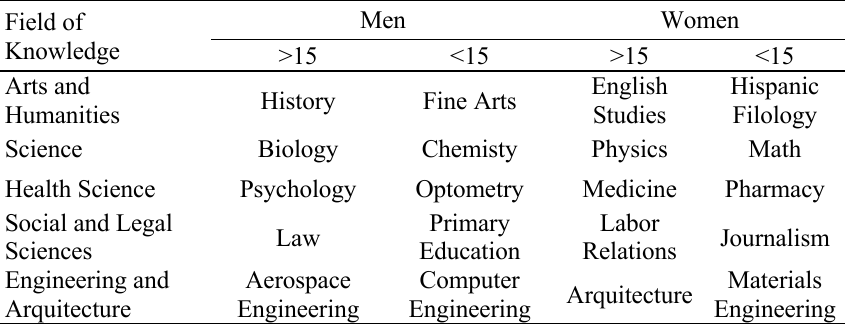
Participants, variables and degrees .